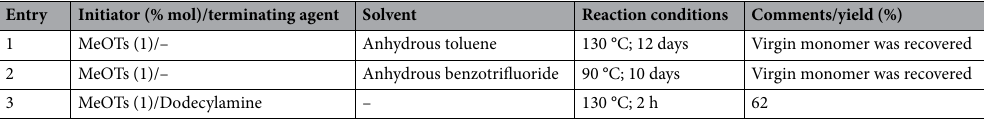
Table 4. Polymerization reaction conditions of TAPOx monomer (initiator, terminating agent, solvent, and reaction conditions) and the obtained results.